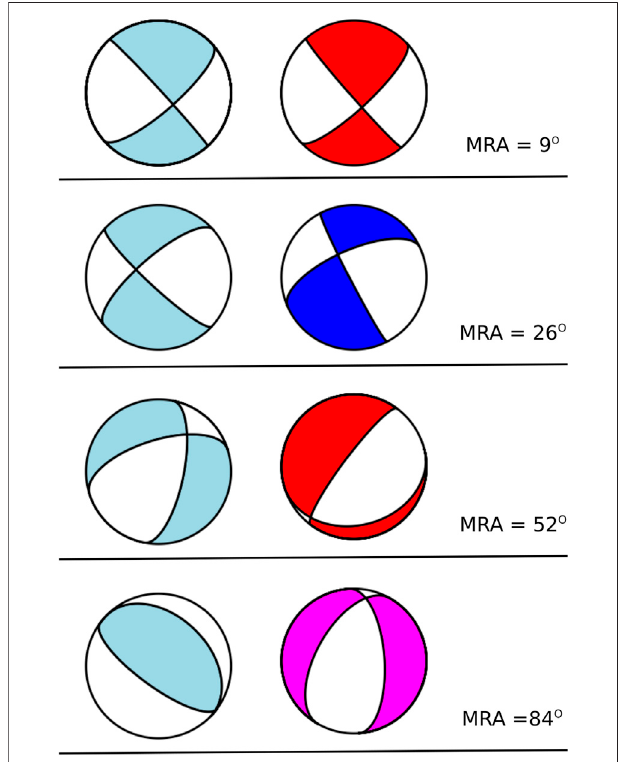
FIGURE 2 | Example of the MRA metric comparing two FM